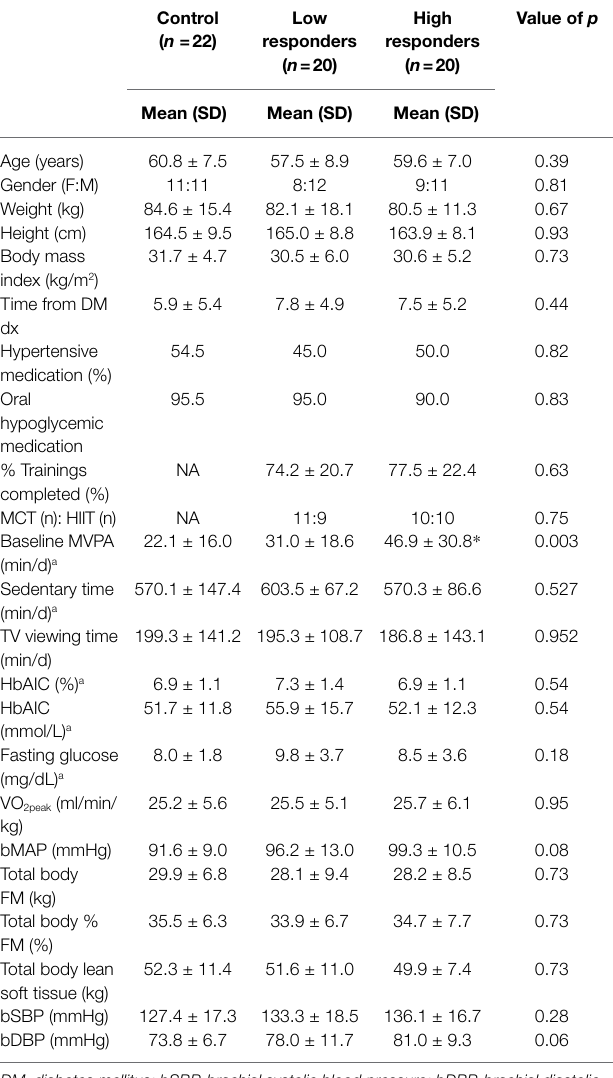
TABLE 1 | Baseline descriptive characteristics of control group and exercise groups who either reduced or did not reduce their total body FM. Control ( n = 22)